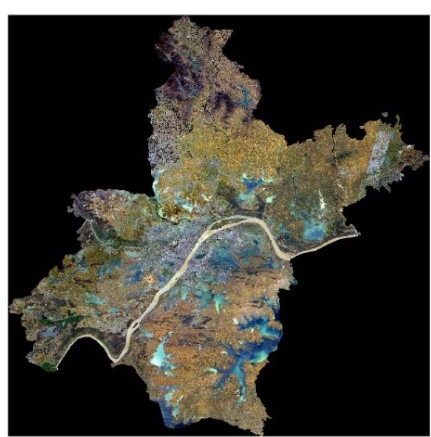
Figure 2 . Schematic diagram of fusion image